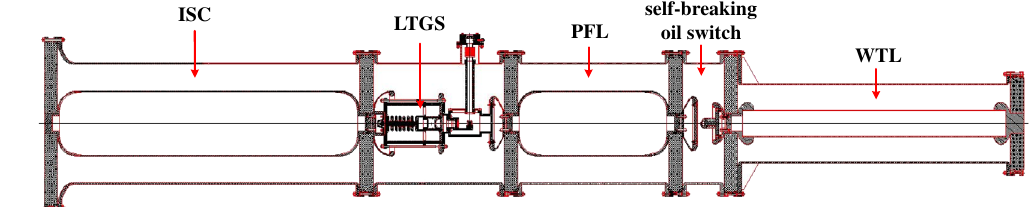
FIG. 5. Cross-sectional view of the pulse forming system. The ISC, PFL, and WTL are filled with deionized water. The regions accommodating the LTGS and self-breaking oil switch are full of transformer oil.